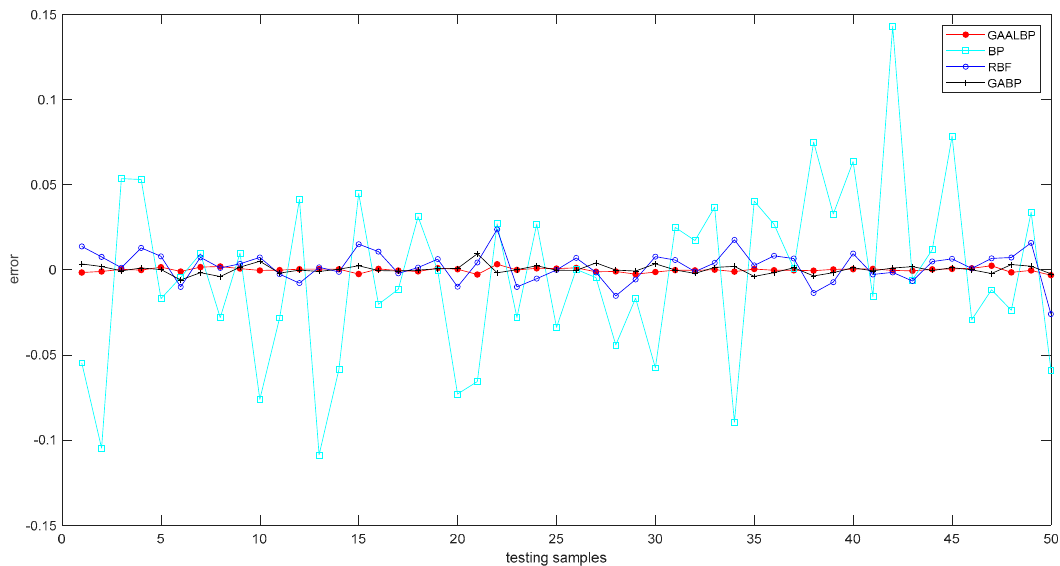
Figure 10. Prediction errors of different networks.